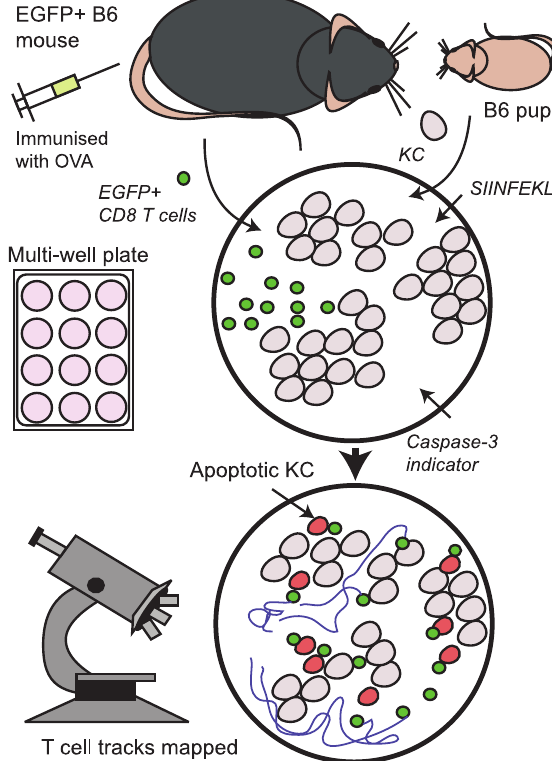
Figure 1. Killing assay. Primary KC from B6 mouse pups were cultured in multi-well plates until 70% confluent, and then loaded with SIINFEKL peptide. Antigen-specific CD8 + T cells from EGFP + B6 mice were isolated and co-cultured with target cells in the presence of cell- permeable caspase-3 indicator dye and imaged by time-lapse fluorescence microscopy or by confocal microscopy every 12 minutes for 30 h. Cell death was noted by colour change, morphology, and